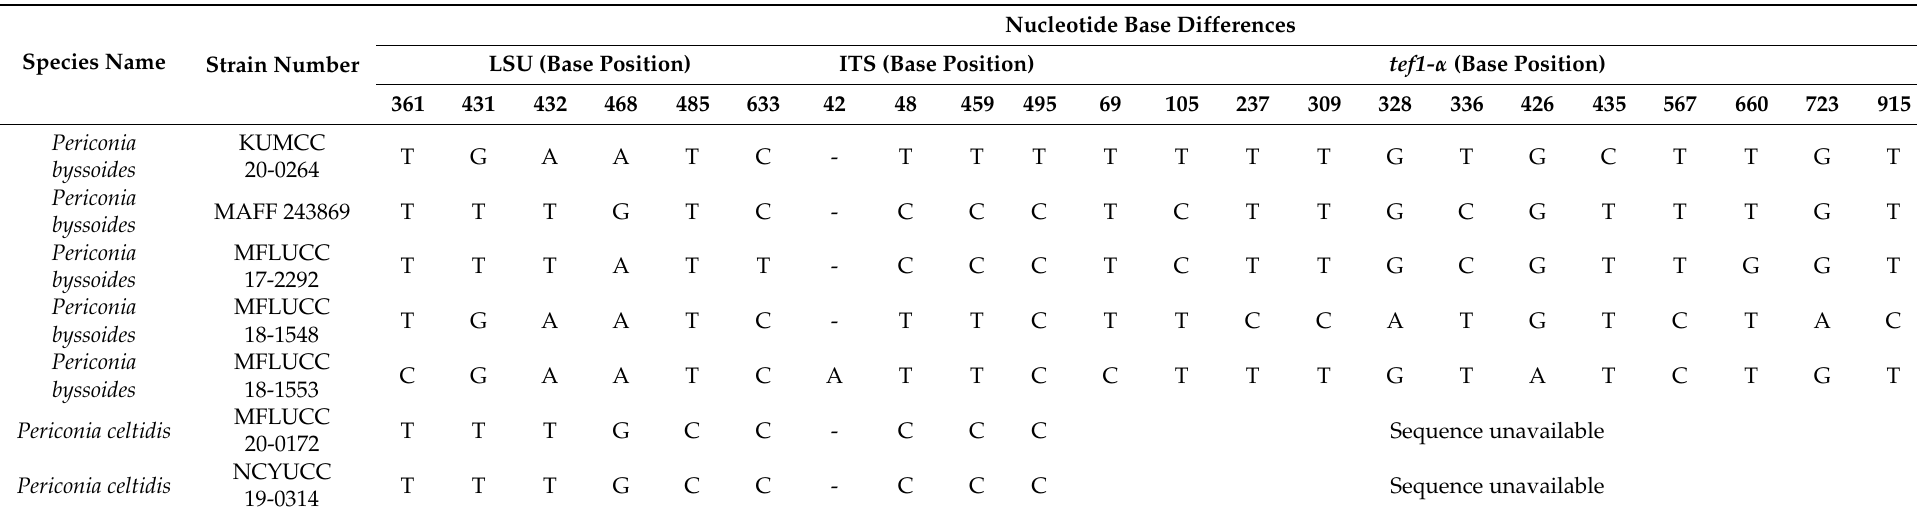
Table 3. Polymorphic nucleotides from the LSU, ITS and tef1- α sequence data of Periconia byssoides and P. celtidis